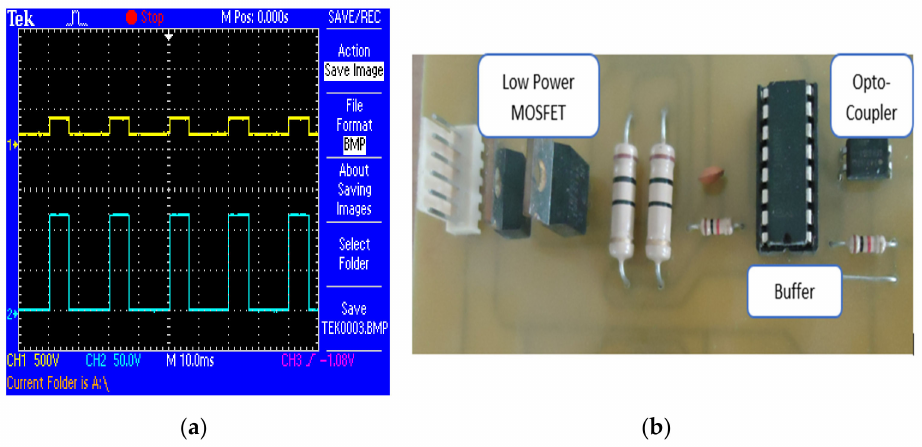
Figure 15. ( a ). Driver input and output, 14. ( b ). Signal Photograph of driver